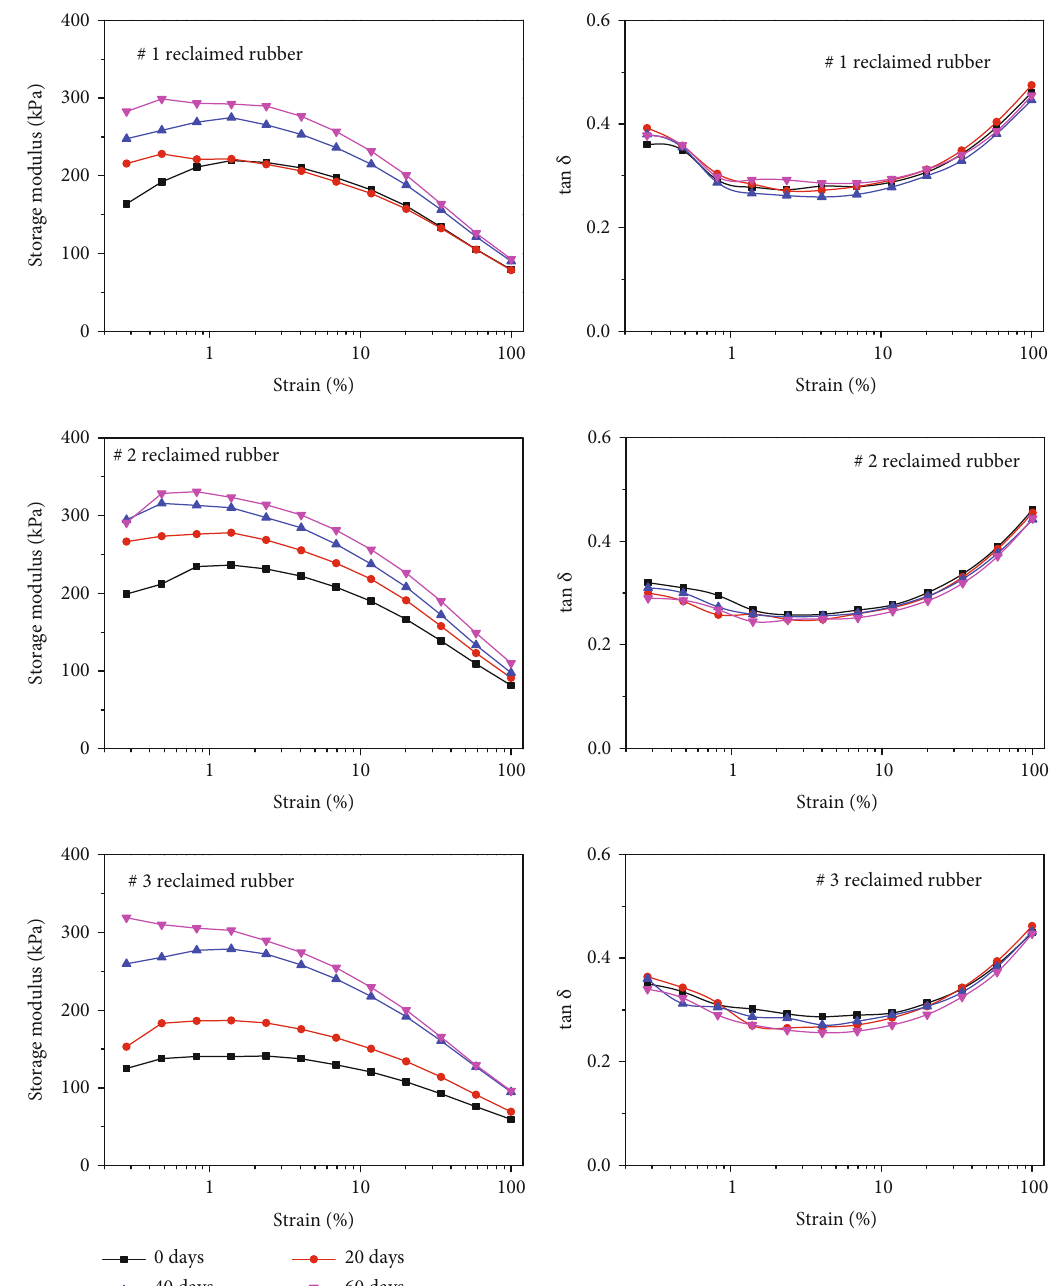
Figure 7: The variation of the storage modulus and tan δ of the di ff erent reclaimed rubber samples with strain amplitude. The G ′ values continuously decrease with increasing strain amplitude; G ′ increases with increasing storage